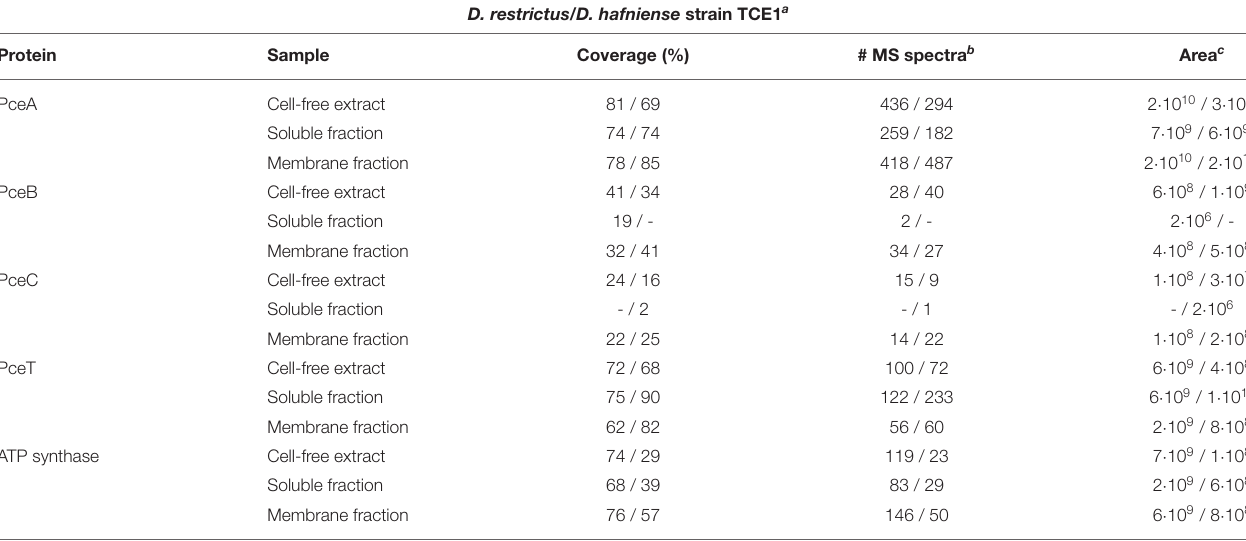
TABLE 1 | Discovery MS analysis on cell-free extracts, soluble and membrane fractions of D. restrictus and of D. hafniense strain